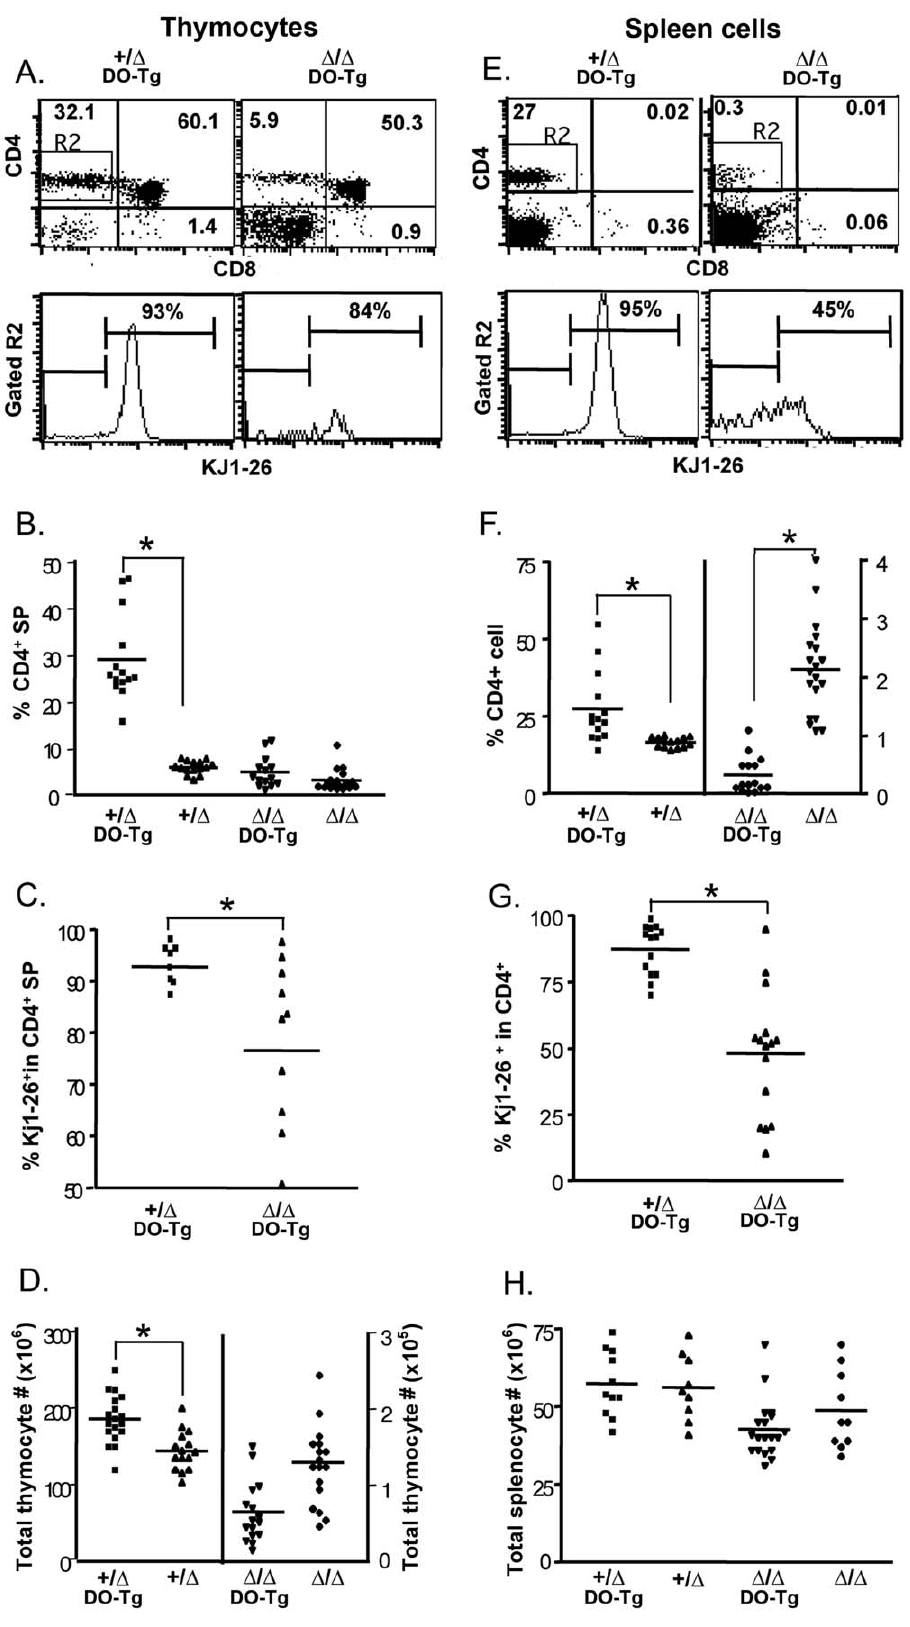
Figure 3. Positive selection for CD4 Tg T cells was greatly reduced in Foxn1 D / D ;DO11.10 Tg mice. Foxn1 D / D ;DO11.10 and Foxn1 D / D ;DO11.10 Tg mice were generated by mating Foxn1 D / D BALB/c mice with DO11.10 CD4 TCR Tg mice, and then CD4 Tg T cells were